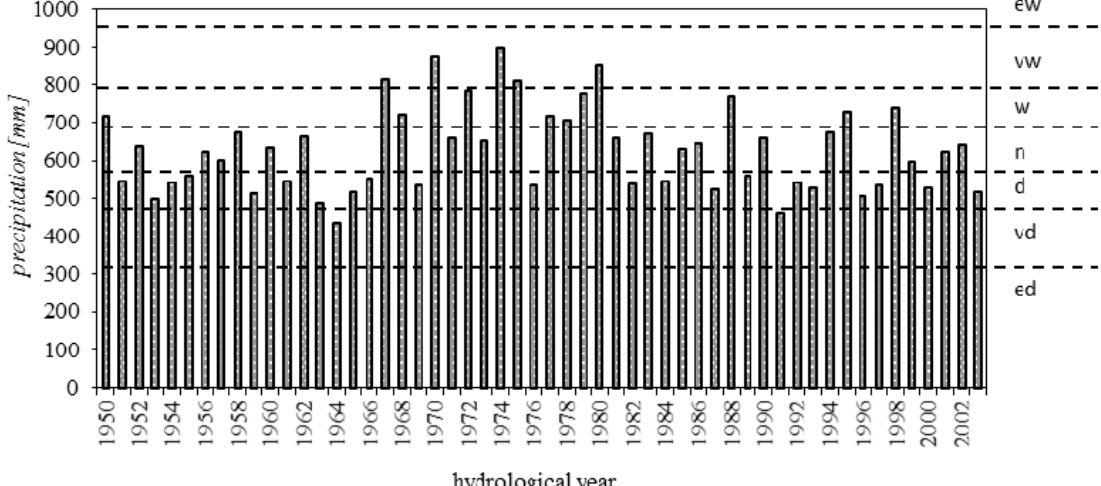
Figure 2. Precipitation in Bialowieza in the period 1950–2003 for hydrological year, (ew—extremely wet, vw—very wet, w—wet, n—normal, d—dry, vd—very dry, ed—extremely dry) [1].